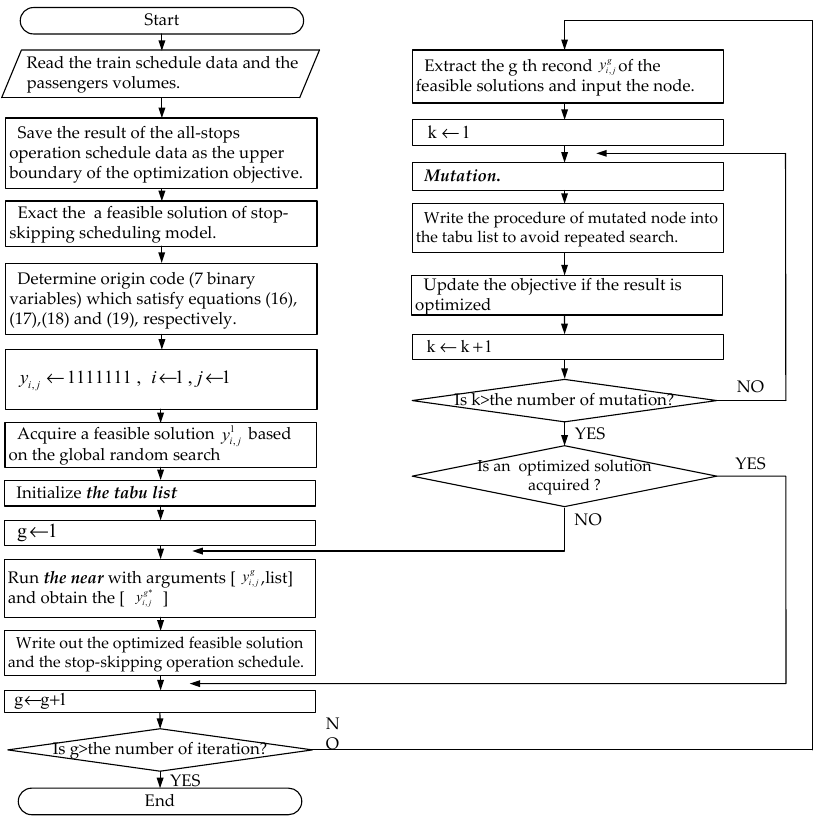
Figure 3. Flowchart of the tabu algorithm.